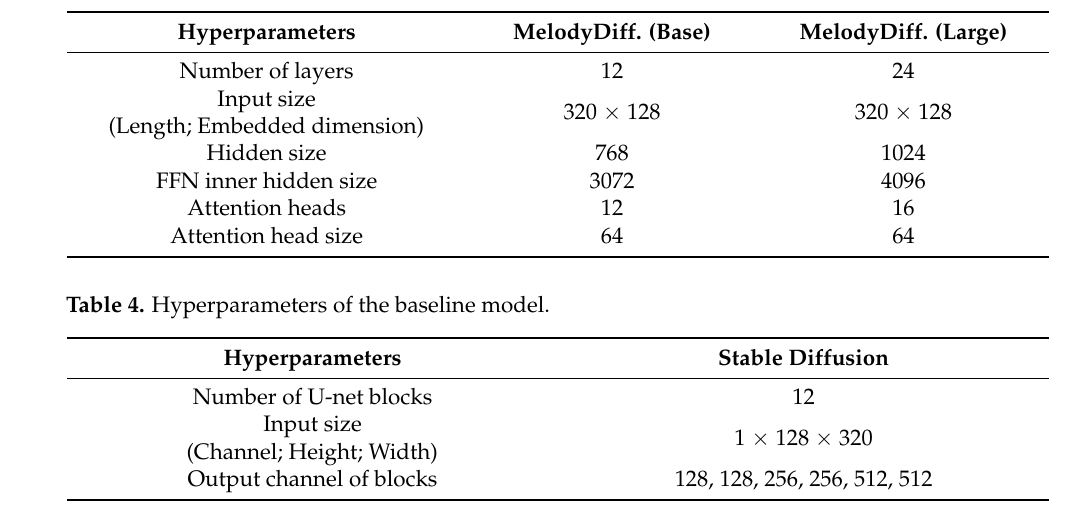
Table 3. Hyperparameters of encoder and denoising model in both the base and large versions of MelodyDiffusion.